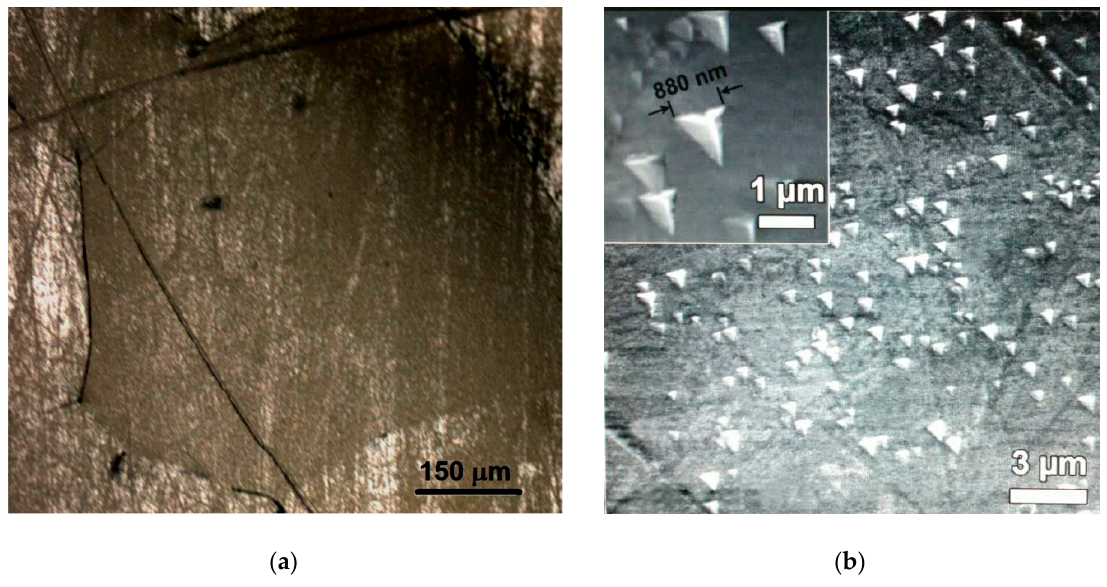
Figure 4. ( a ) The blocky structure of peripheral crystal areas; ( b ) Dislocation etching pits pattern on (111) crystallographic ScF 3 crystal face.